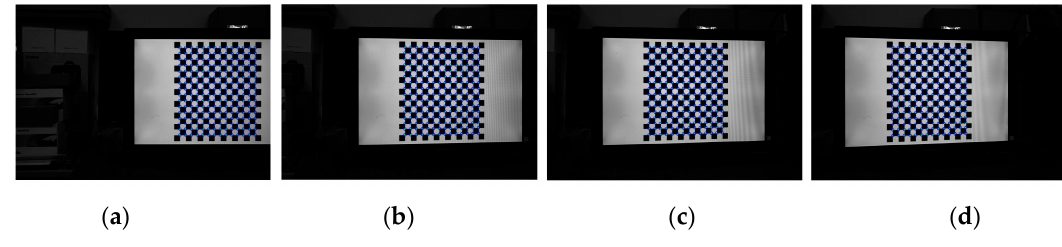
Figure 18. The checkerboard images of ( a ) 0°; ( b ) 6°; ( c ) 9°; ( d ) 12°.